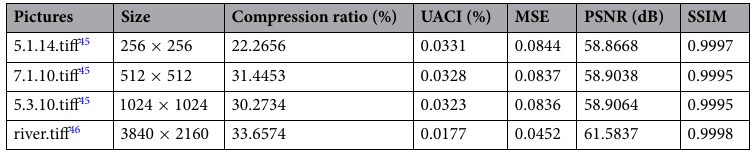
Table 3. Image restoration quality analysis.